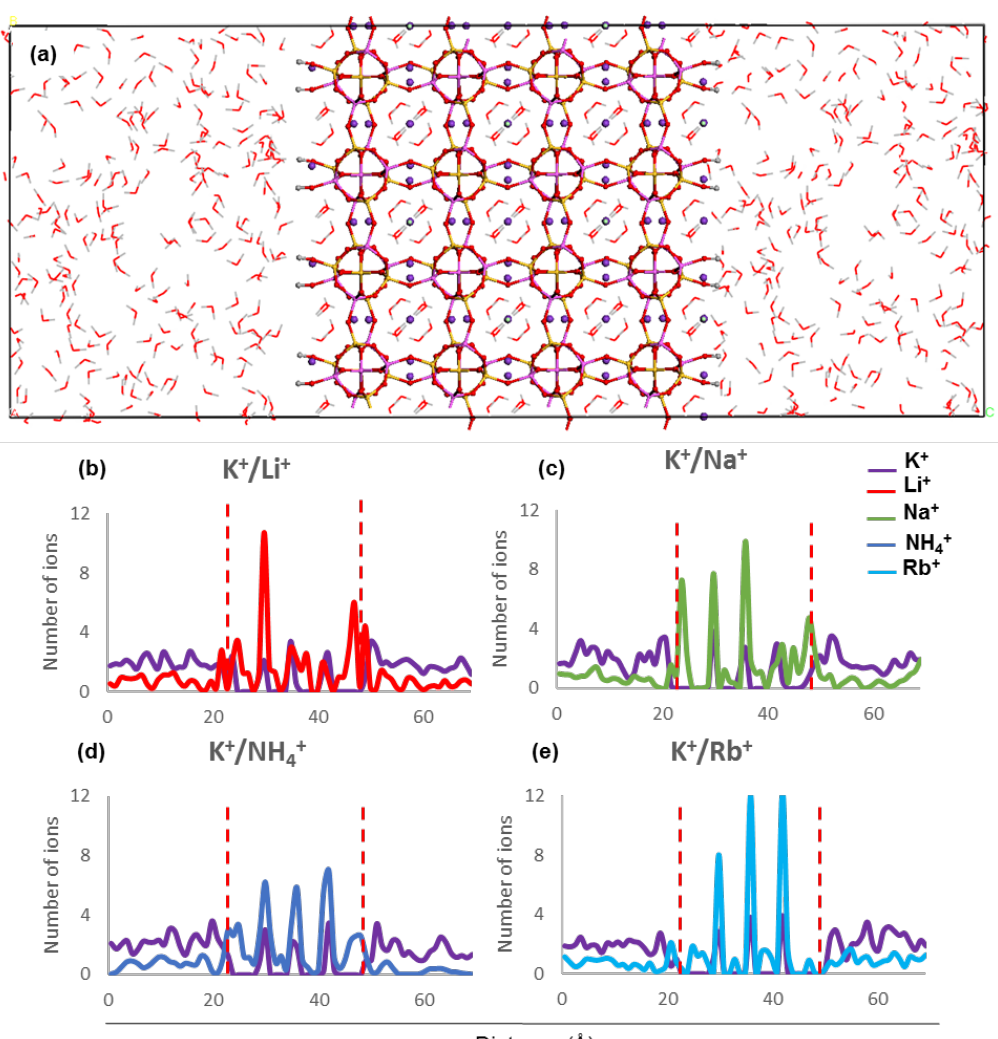
Figure 3. ( a ) ZM-110 simulation box along the z direction and ( b – e ) ion concentration profiles along the z direction after 8.5 ns MD simulations. The two red dashed lines indicate the location of ZM-110 surfaces in the electrolyte solution.